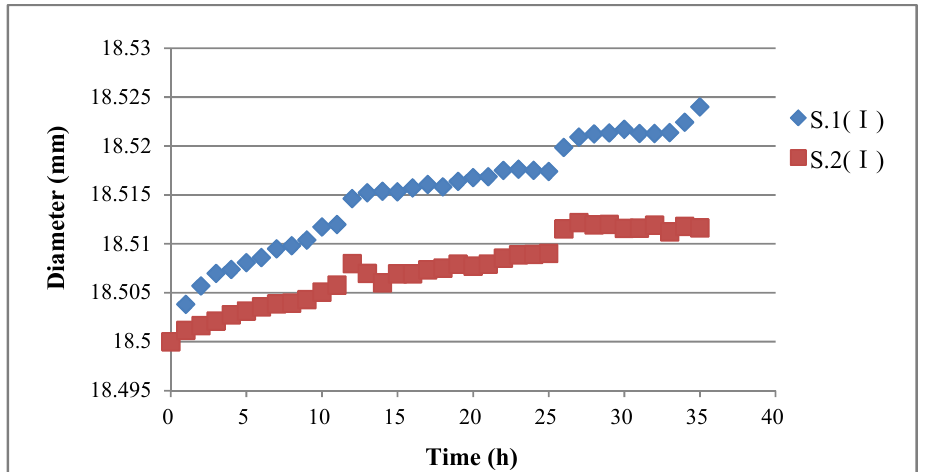
Figure 15. Steel rebar diameter monitored of sensor S.1 (I) and S.2 (I).